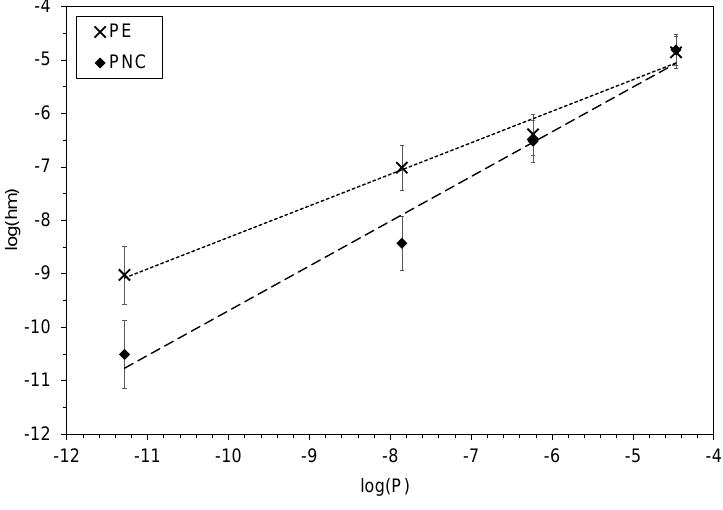
Figure 4. Relationship between the external mass transfer coefficient (Equation (2)) and the theoretical vapor pressure (Equation (15)) of the contaminants. Dotted lines are for